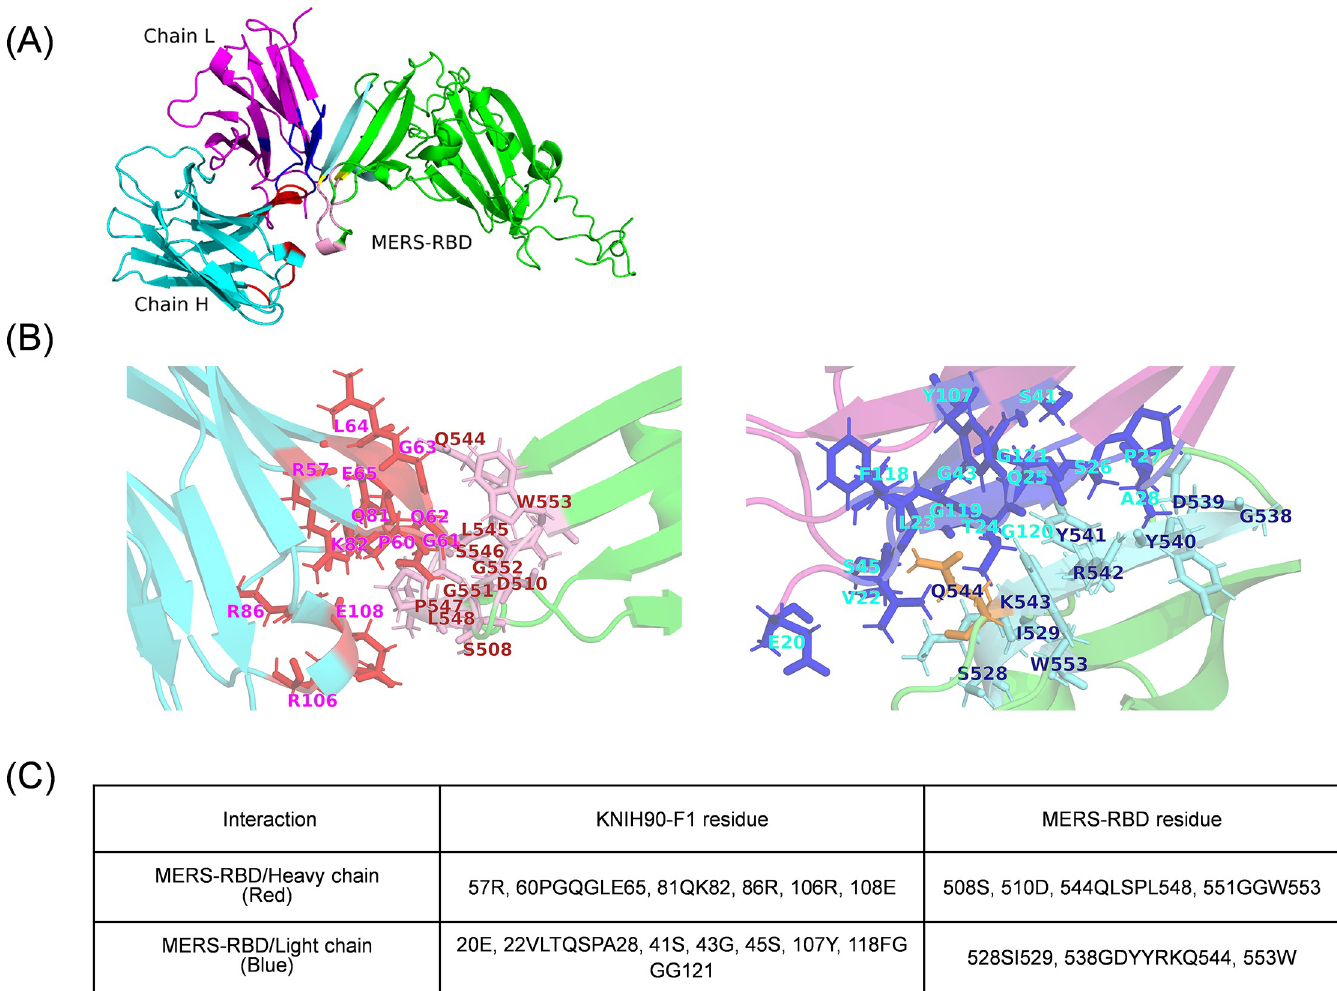
Fig 3. Proposed docked structure of the RBD and mAb. (A) A docked complex of the RBD and the KNIH90-F1 variable region. Green: RBD; cyan: heavy chain; magenta: light chain; red: interface residues of RBD with the heavy chain; pink: interface residues of the heavy chain; blue: interface residues of RBD with light chain (L); sky blue: interface residues of the light chain; yellow: overlapped interface residues in the heavy and light chains. (B) Interaction of the RBD and KNIH90-F1 complex. Interface residues of the RBD and heavy chain (left) and light chain (right). (C) Summarized putative interaction residues of the RBD, heavy chain, and light chain.